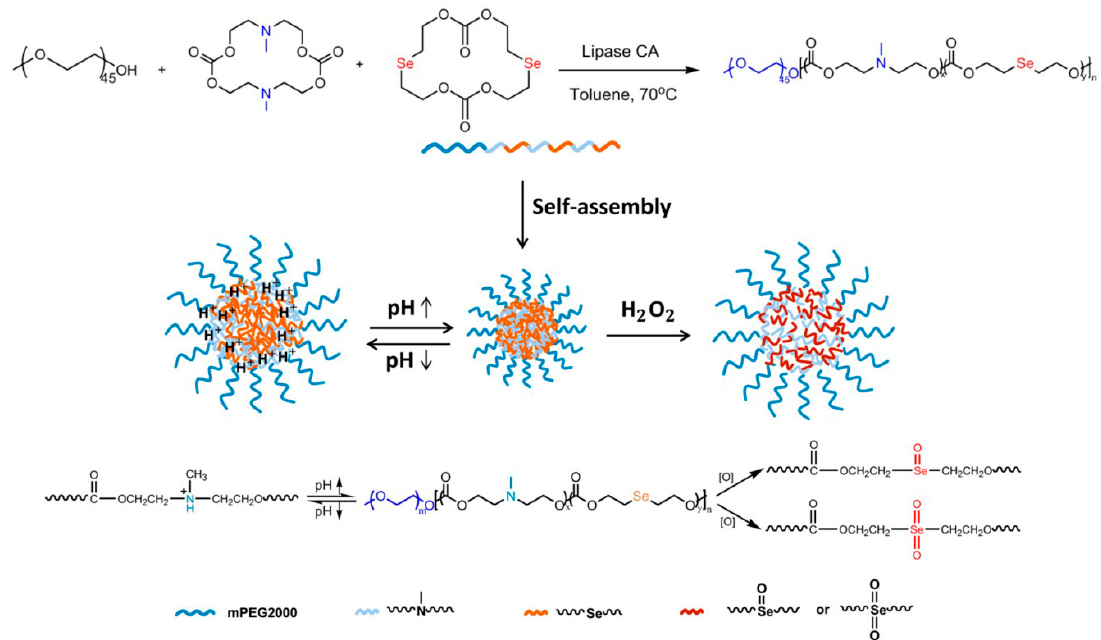
Figure 10. ( Top ) Synthesis of PEGylated APC containing selenide and tertiary amine groups in the polymer backbone by lipase-catalyzed ring-opening copolymerization. ( Bottom ) Schematic illustration of dual-responsive nanocarriers for ROS/pH-controlled drug release. Reprinted with permission from ref [160]. Copyright 2019 Royal Society of Chemistry.